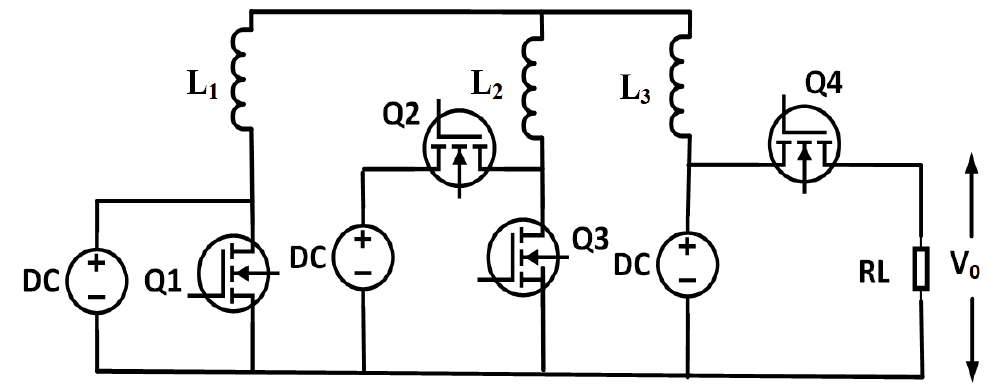
Figure 16. Hybrid non-isolated three-port buck–boost converter with two bidirectional ports.